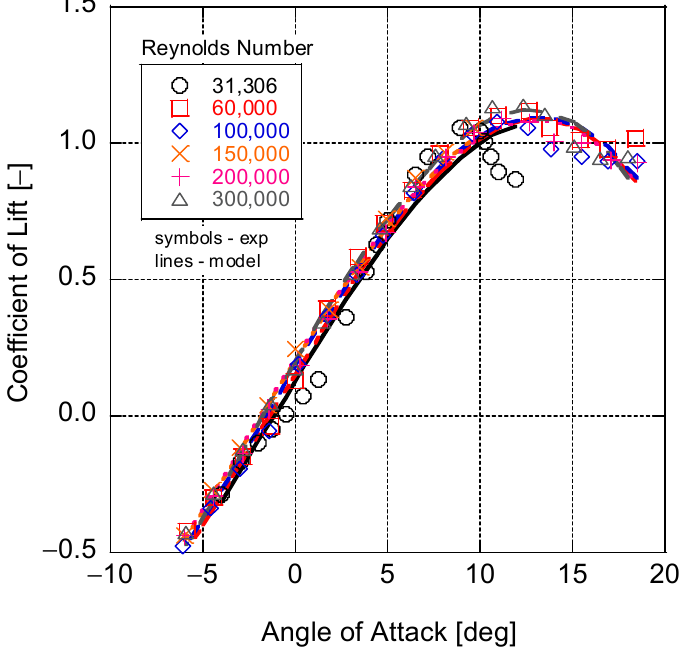
Figure 7. Use of K–J theorem to match C l as a function of AoA with a quadratic Re number relation- ship. Table 2. Coefficients for the C l quadratic Re number model.